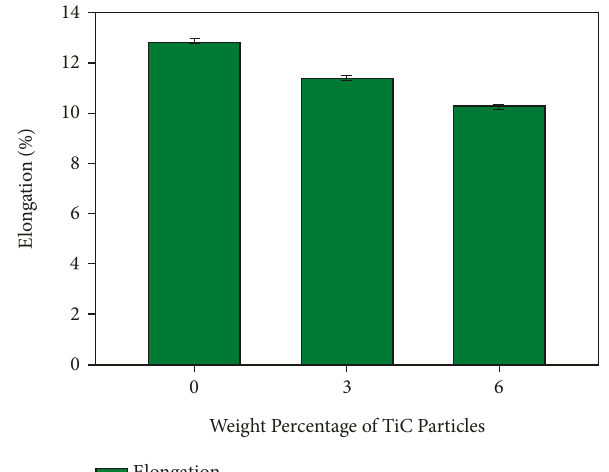
Figure 10: Elongation of Al7075 alloy with TiC